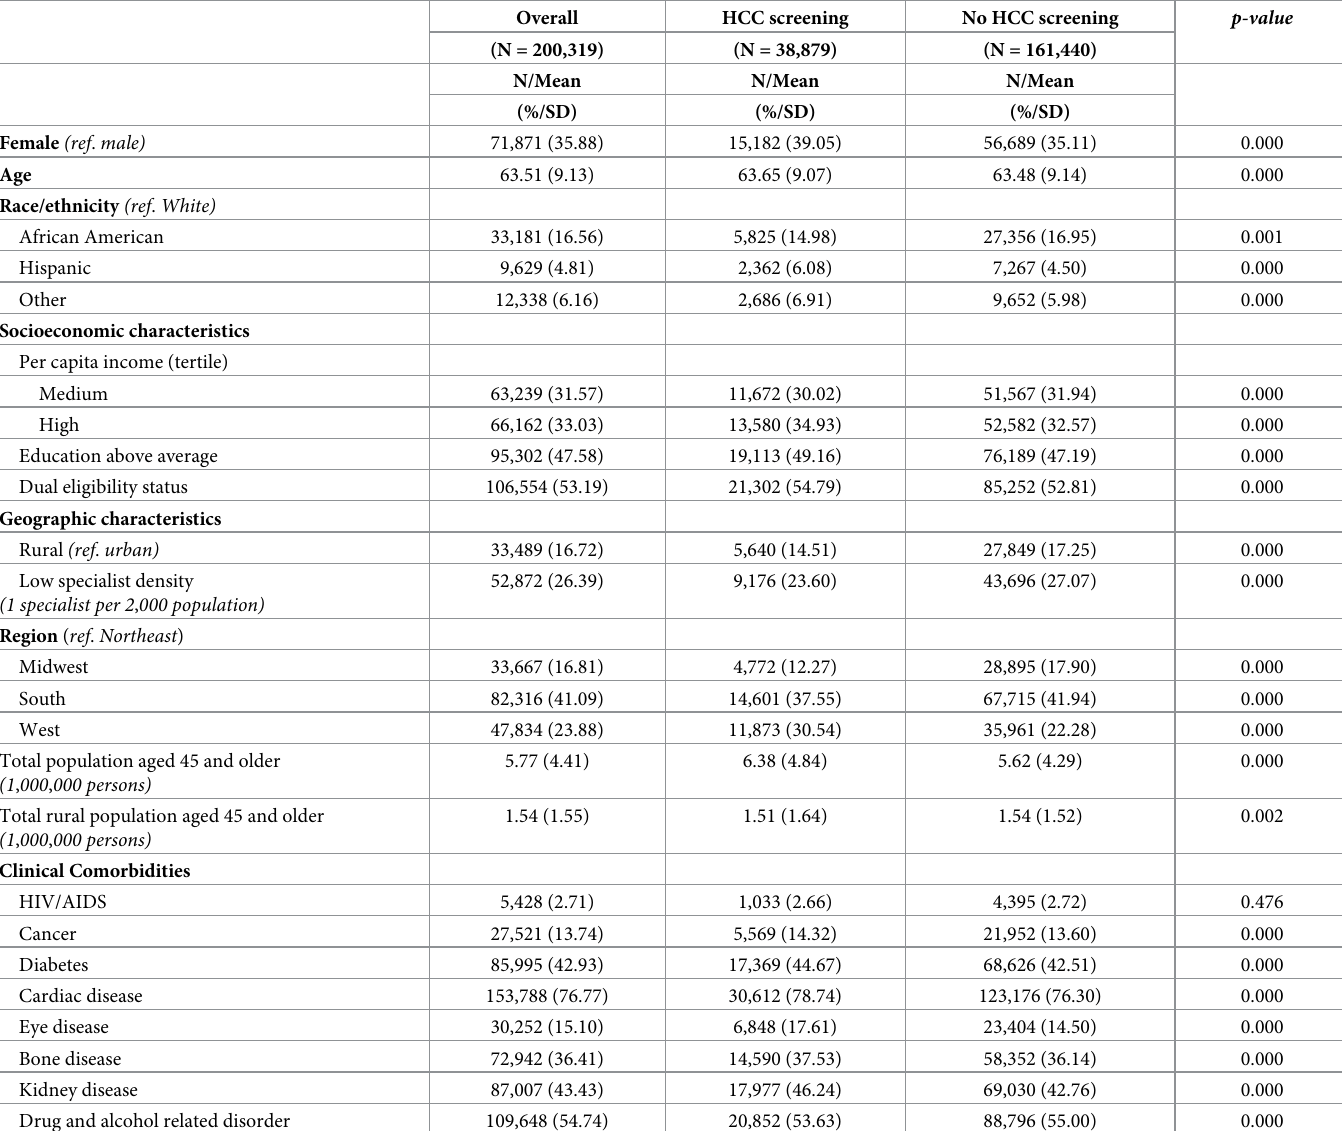
Table 3. Descriptive data for the analysis of semi-annual hepatocellular carcinoma (HCC) screening with ultrasound among Medicare beneficiaries with hepatitis C and cirrhosis.